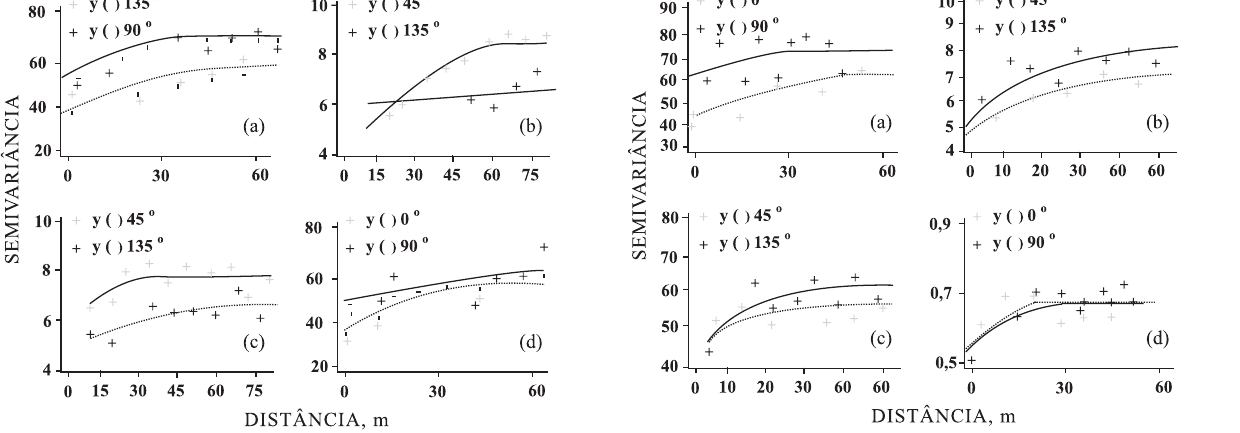
resíduos de MO, Mn e H + Al